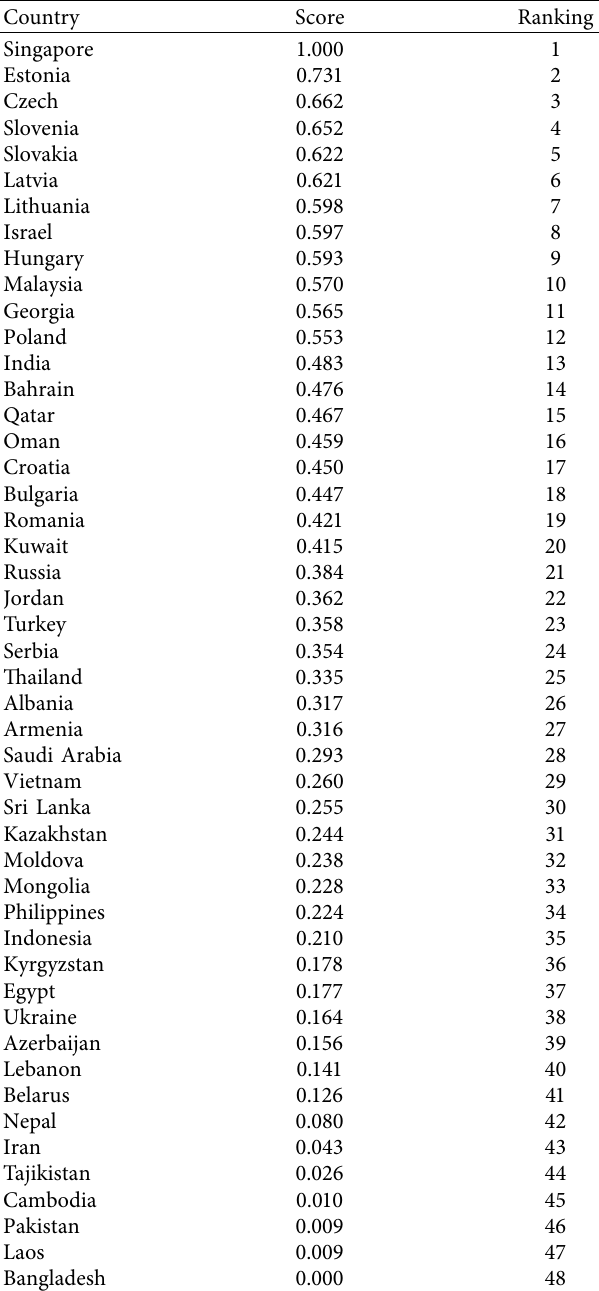
Table 5: Ranking of BRI